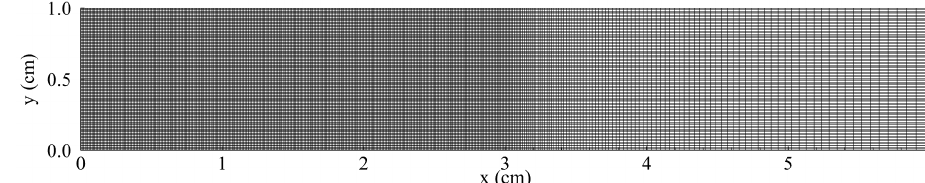
Figure 1. Computational domain for the analysis of detonation instabilities.